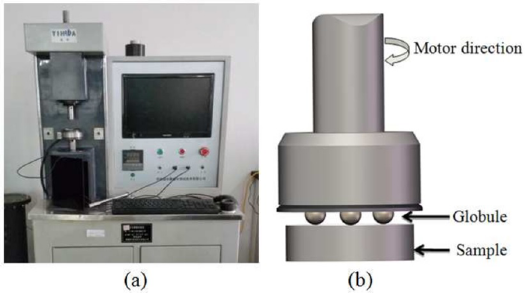
Figure 2. MMW-1A universal friction and wear testing machine: (a) experimental setup and (b) working principle